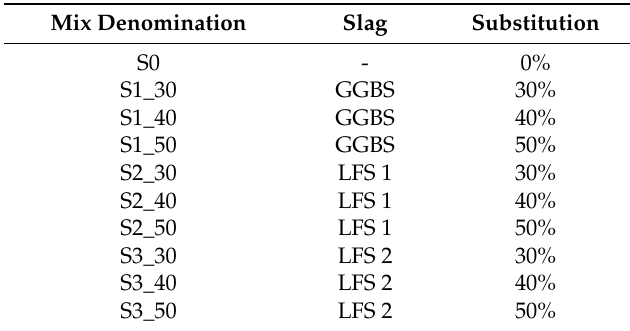
Table 2. Cementitious grout mixtures